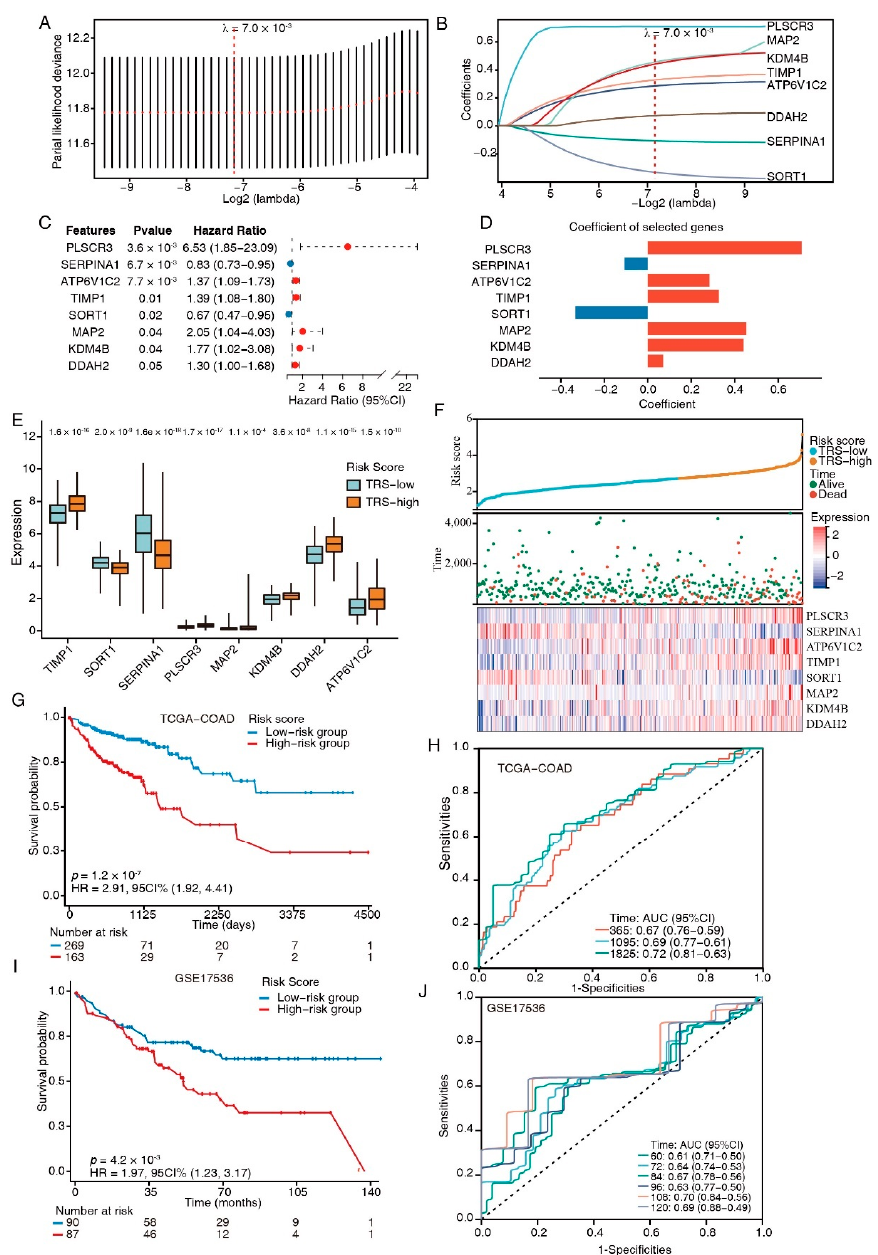
Figure 4. TFEB-related gene signature establishment. ( A ) Selection of the optimal LASSO parameter lambda; vertical lines indicate the optimal values. ( B ) LASSO coefficient profiles of the 8 candidate genes. ( C ) Forest plots of the 8-gene signature. ( D ) Coefficients of the eight genes. ( E ) Boxplots showing the 8-gene signature expression levels between high- and low-risk-score groups. ( F ) The distributions of the risk score and survival status of CRC patients, and the heatmap showing the eight genes’ expression profiles. ( G ) K–M survival curves for patients at high and low risk in the TCGA-COAD cohort. ( H ) ROC plot and AUC scores for predicted OS by the TRS in the TCGA-COAD cohort. ( I ) Kaplan–Meier survival curves of OS between high- and low-risk patients in the GSE17536 dataset. ( J ) ROC plot and AUC scores for predicted OS by the TRS in the GSE17536 dataset.